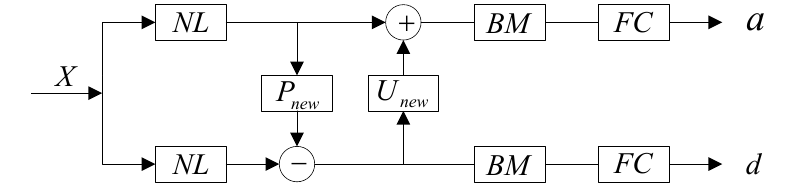
Figure 5. Block diagram of improved forward transform of nonlinear redundant lifting wavelet